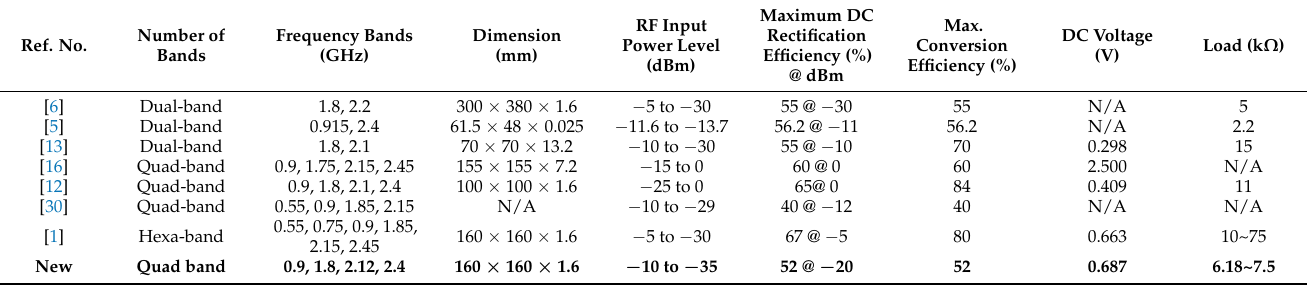
Table 5. Comparison between the proposed harvester and some related